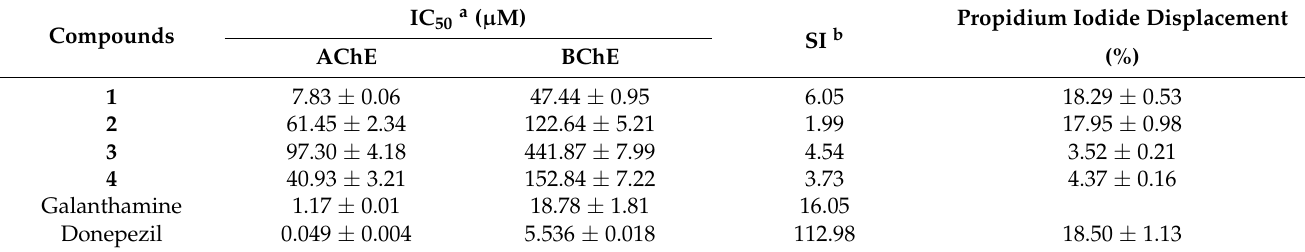
Table 1. Inhibitory activity on cholinesterase and propidium iodide displacement by compounds 1–4 .